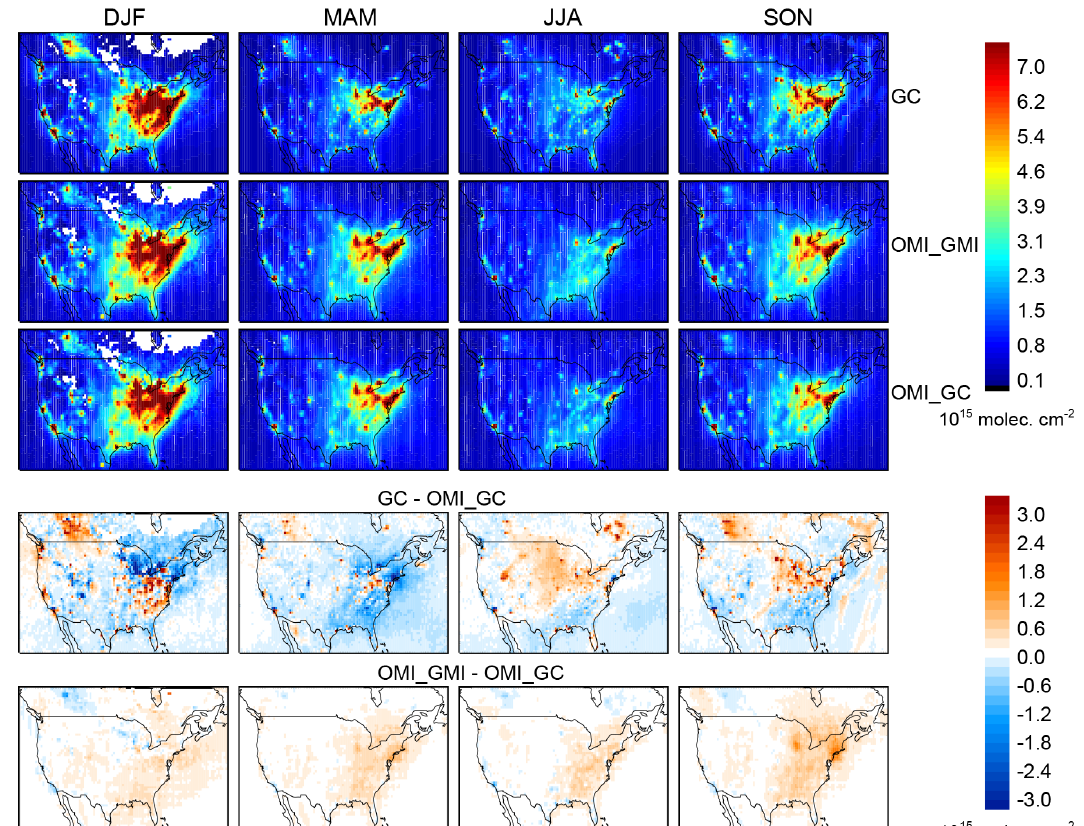
Figure 13. Seasonal mean tropospheric NO 2 columns binned at 0 . 5 ◦ × 0 . 667 ◦ latitude × longitude over North America for 2005 from GEOS- Chem (first row), OMI standard product (OMI_GMI, second row), and OMI retrievals using the GEOS-Chem NO 2 a priori vertical profiles (OMI_GC, third row). White areas represent regions with insufficient data. The bottom two rows show the difference between (fourth row) GEOS-Chem and OMI_GC, and (fifth row) OMI_GMI and